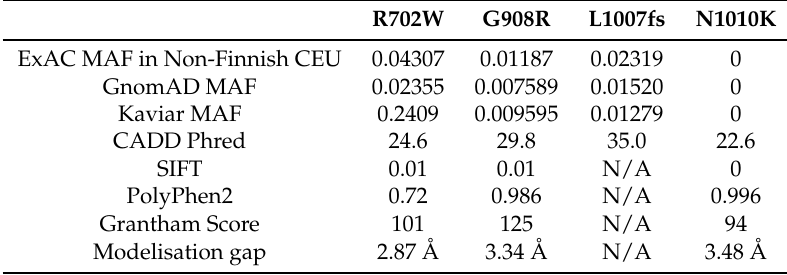
Figure 1. ( A ) Pedigree of family F49M with segregation of the c.3030A>C; p.(N1010K) and c.3019dupC; p.(L1007fs) variations. ( B ) Chromatograms for NOD2 coding region in exon 11. The red arrows show the c.3030A>C nucleotide substitution consisting of the amino acid substitution N1010K. The black arrows show the c.3019dupC frameshift variation (rs2066847). Table 1. Comparison of N1010K variation and known variations associated with CD: R702W and G098R. Indicators of in silico prediction of the deleterious effects of NOD2 variations. CADDPhred: global potential deleterious effect, SIFT: protein potential deleterious effect, PolyPhen2: protein domain potential deleterious effect, physico-chemical gap: physico-chemical gap between the 2 AA (Grantham score), modelisation gap: modelisation mid-gap between α